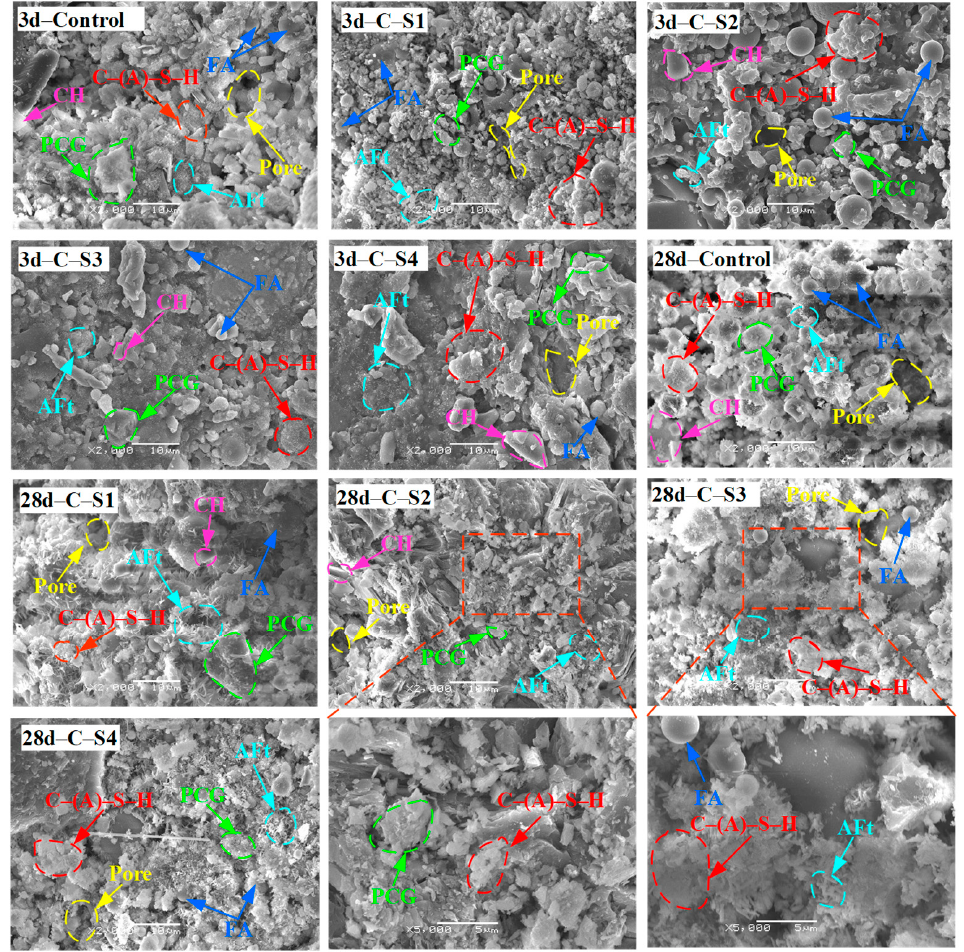
Figure 12. SEM results of